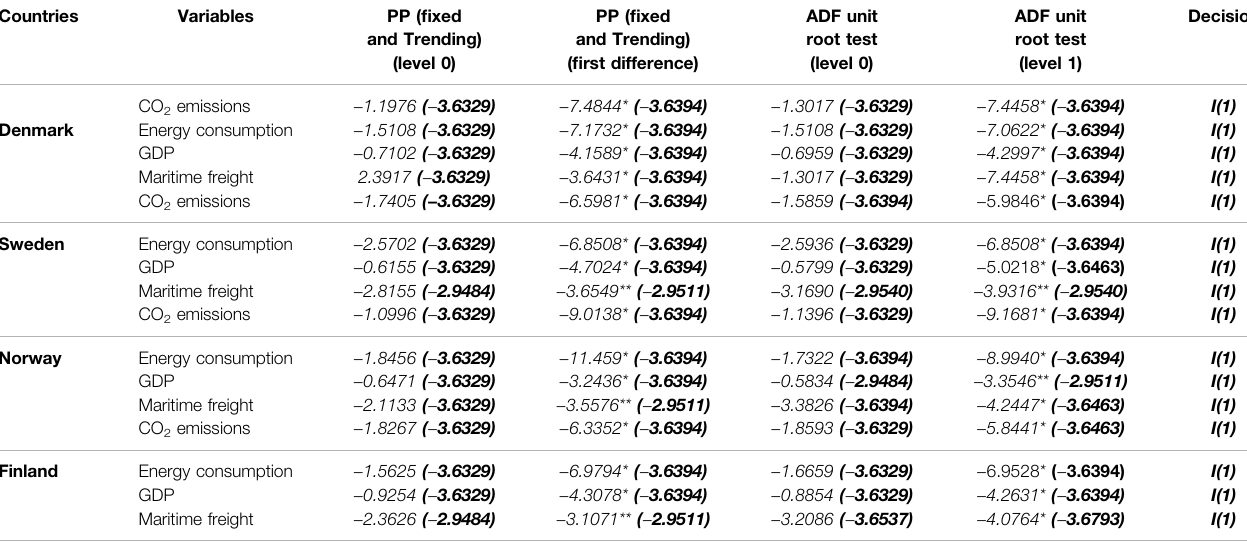
TABLE 2 | Phillips – perron (PP) and augmented dickey – fuller (ADF) unit root test results of Scandinavian countries.